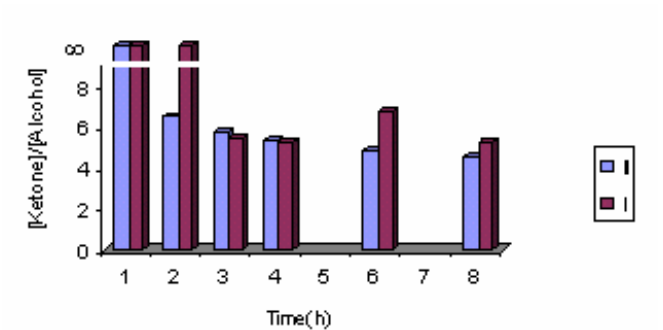
Figure 7. Variation of the [acetophenone]/[1-phenylethanol] ratio vs. time for experiments 1 and 8.